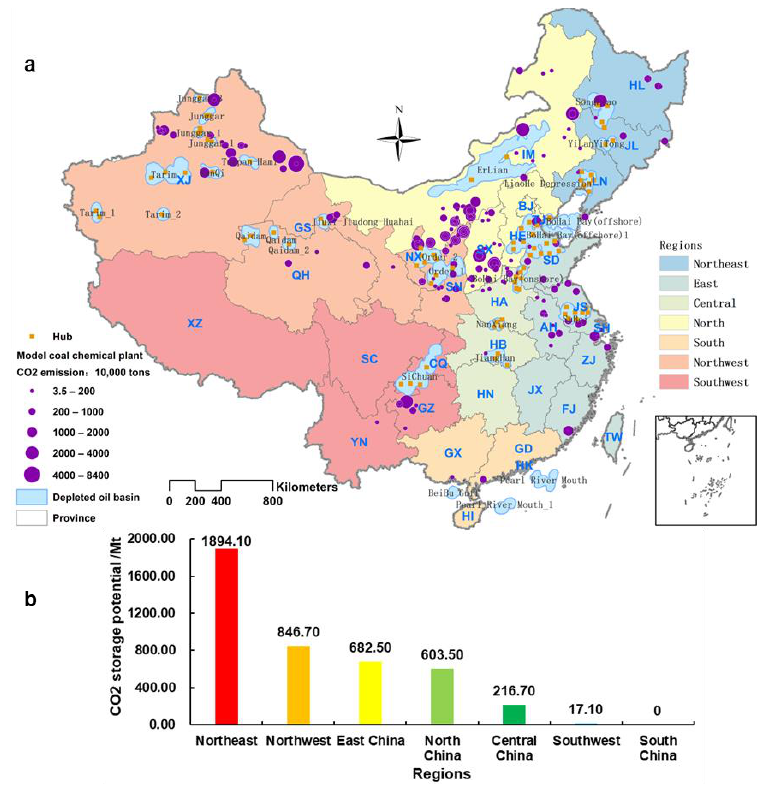
Figure 2. Distribution of modern coal chemical plants and hub. a shows the source-sink layout of the country, and b shows the CO 2 storage potential of EOR in various regions of the country. the country, and ( b ) shows the CO 2 storage potential of EOR in various regions of the